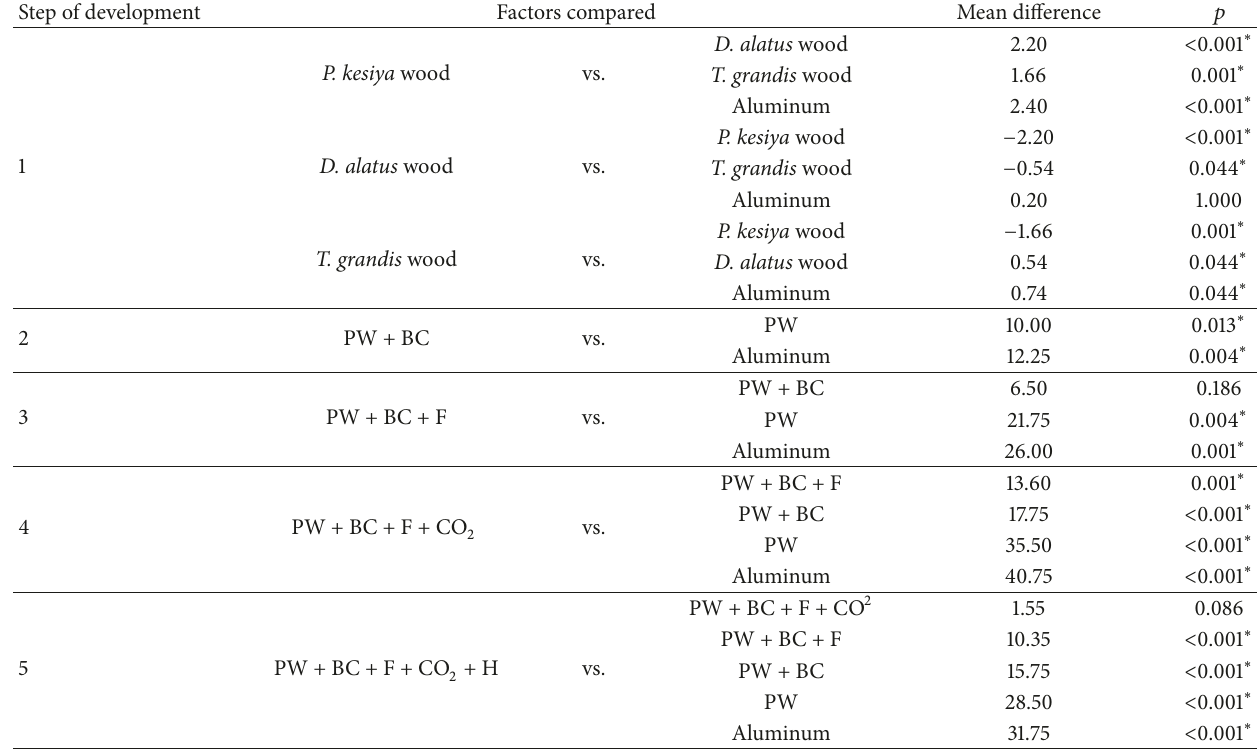
Table 2: Comparison of the mean number of mosquitoes caught by each type of trapping box in each step of development. Step of